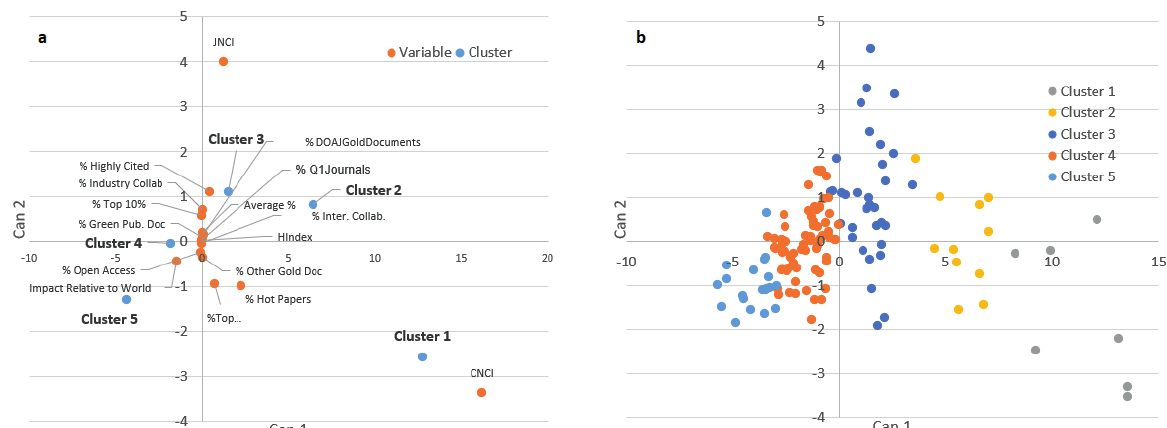
Figure 7. Canonical analyses for university classifi cation in Brazil showing means cluster and variables (a) and individual universities (b). (Cluster 1 has highest impact factor and Cluster 5